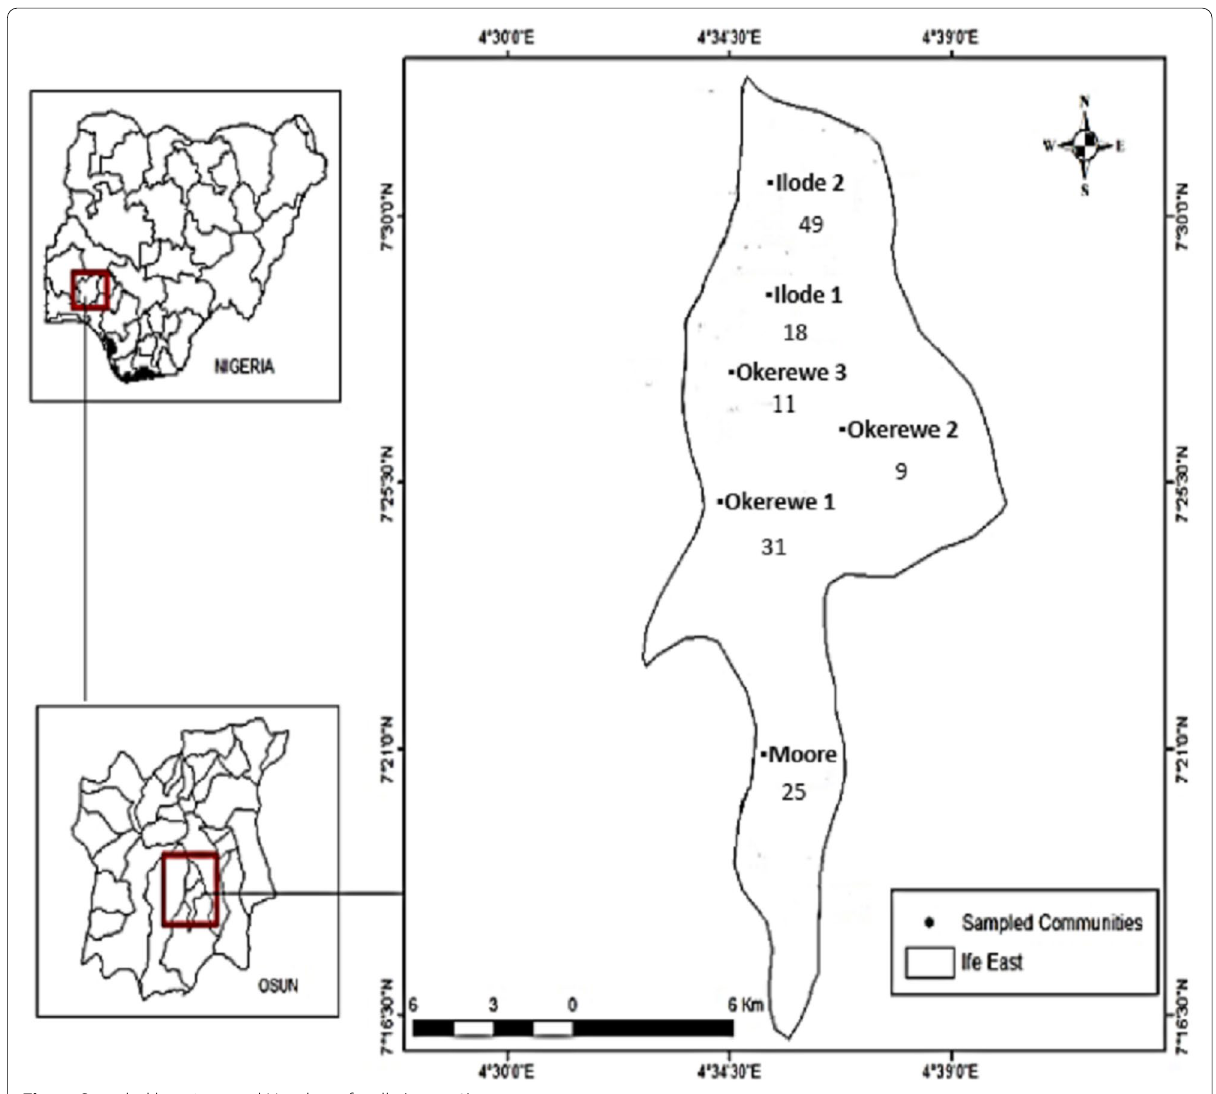
Fig. 1 Sampled locations and Number of wells ( n